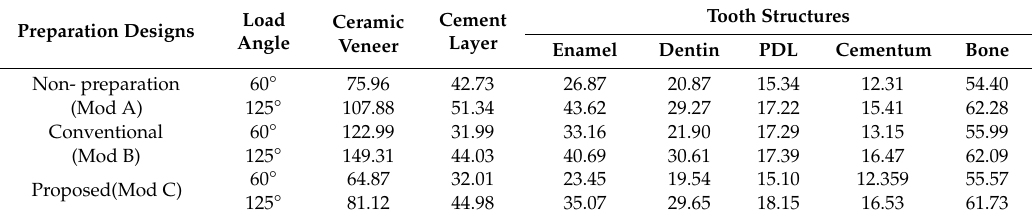
Table 2. Peak von Mises stress values (MPa) for all tested models with varying preparation designs and loading